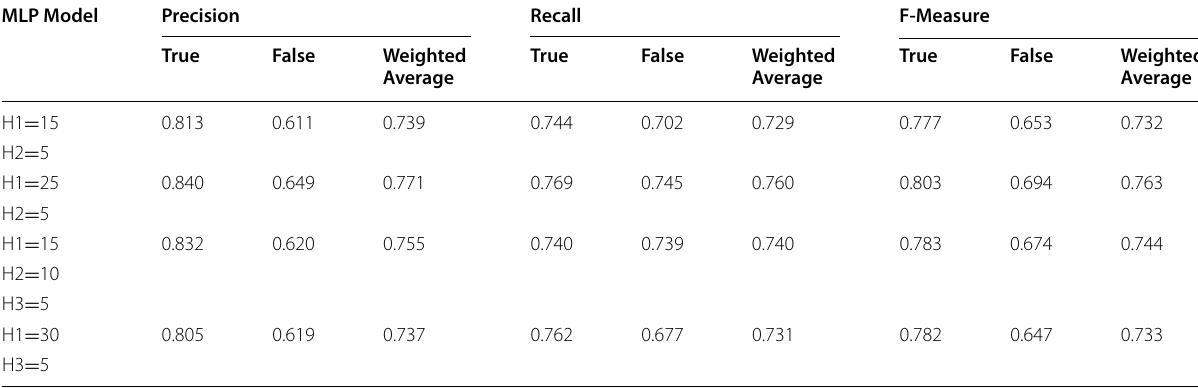
Table 5 Results obtained for Poi 3.0 dataset MLP